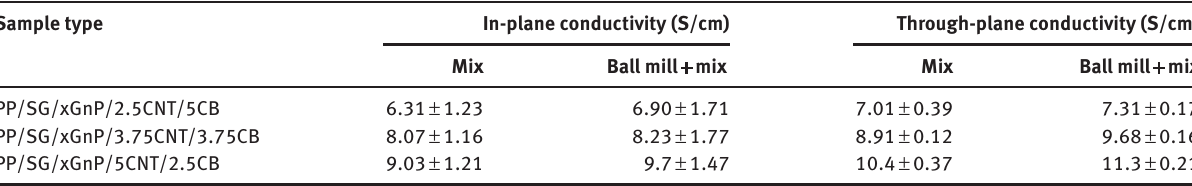
Table 4: The electrical conductivities of the PP composites combined with the MWCNTs and CB. Sample